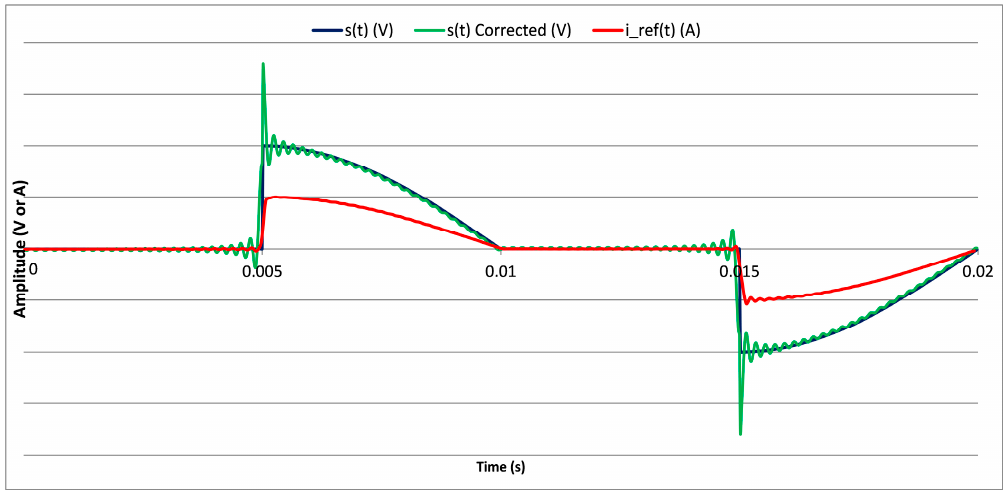
Figure 14. Targeted, corrected and acquired 90° phase-fired waveform.